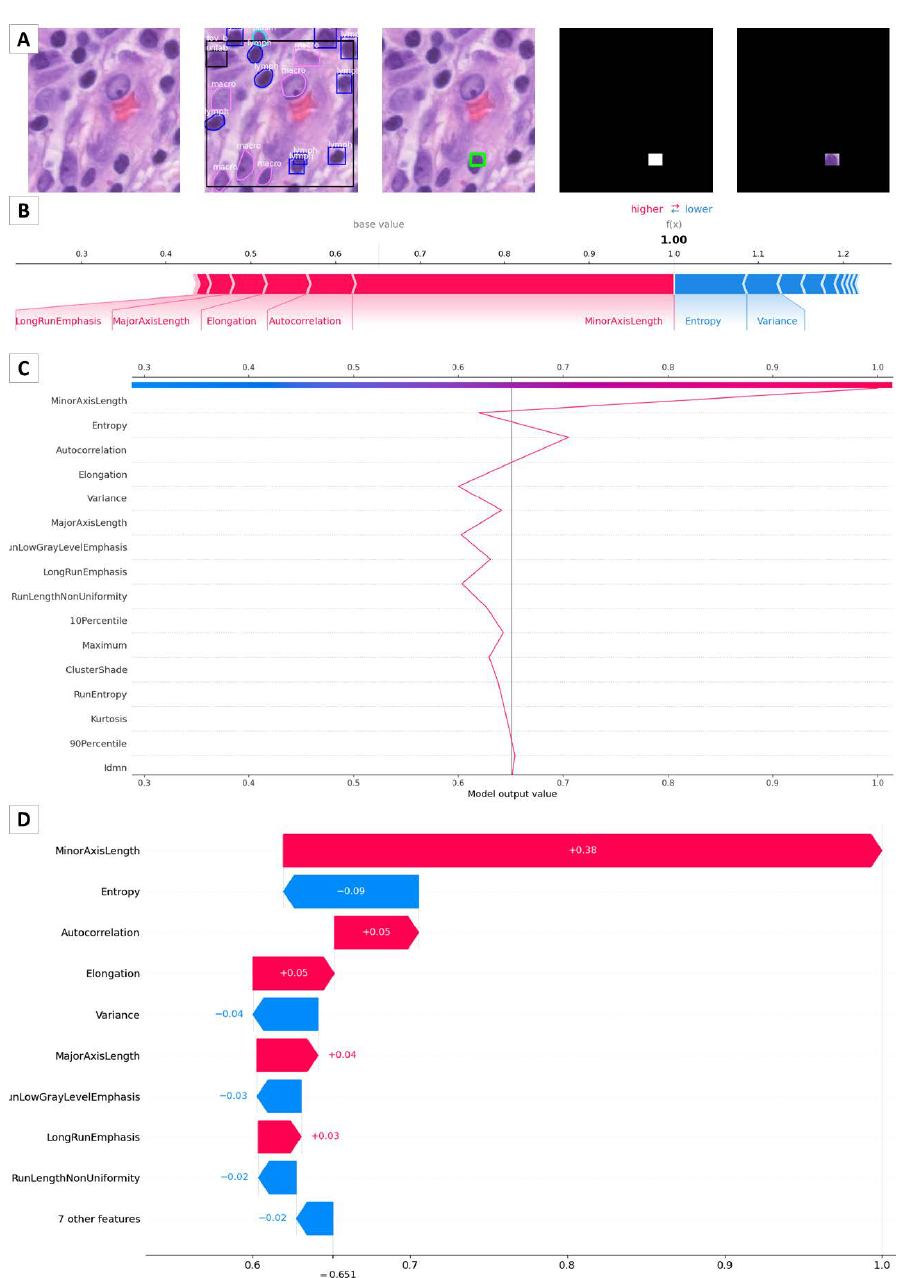
Figure 8. ( A ) Example nucleus . The first row depicts a lymphocytic nucleus that has been considered as a sample on which to perform the investigation of feature importance analysis. ( B ) Force plot . The stripes in the figure demonstrate the feature impact with respect to the target variable. In detail, the red and blue stripes display the features increasing and decreasing the base value, respectively. ( C ) Decision plot . The plot depicts the decision graph, which allows for the inspection of the magnitude of each decision change according to the features. ( D ) Waterfall plot . The plot portrays an outlook of the magnitude and sign of the impact of each feature.